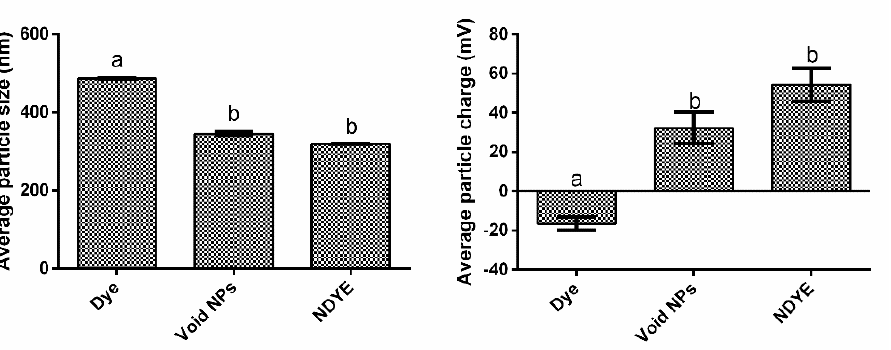
Figure 1. Average particle size (nm) and average particle charge for the free dye, void nanoparticles (NPs) and nanoencapsulated yellow everzol dye (NDYE). Different letters represent the statistically significant ( p < 0.05) differences found between conditions assayed.